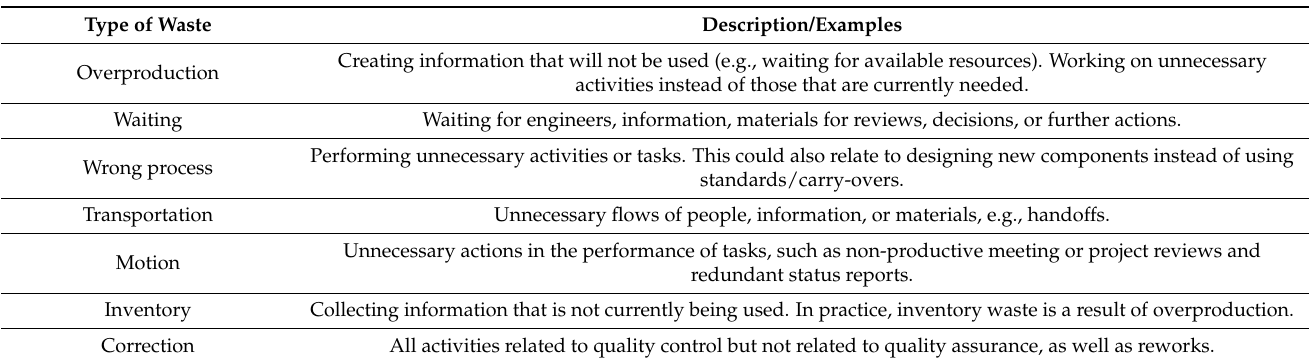
Table 1. Types of waste in NPD processes. Source: Authors’ own, based on [18]. Type of